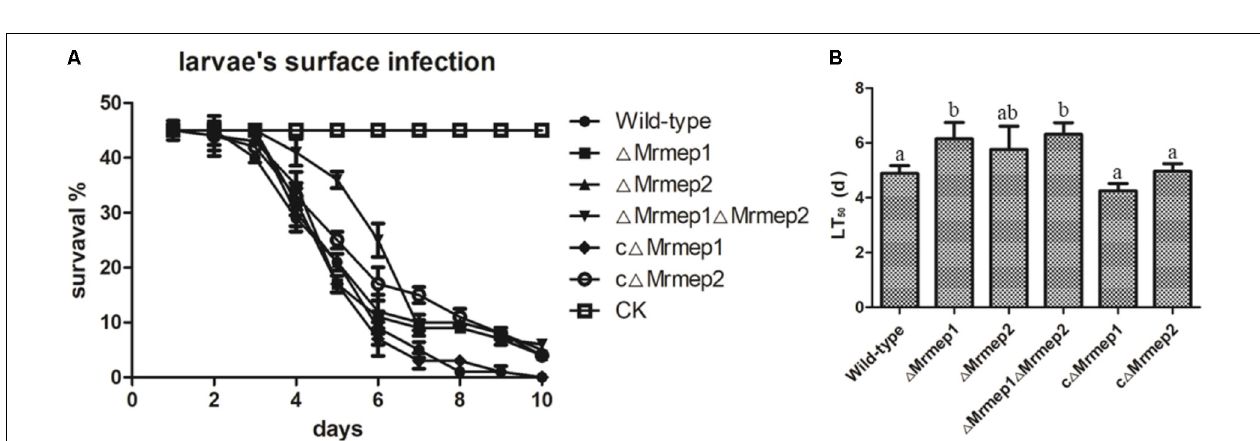
FIGURE 5 | Insect bioassays to assess the loss of Mrmep1 and Mrmep2 using the larvae of G. mellonella as hosts. (A) Survival curves of G. mellonella larvae after injection with fungal conidia of WT, (cid:49) Mrmep1 , (cid:49) Mrmep2 , (cid:49) Mrmep1 (cid:49) Mrmep2 , c (cid:49) Mrmep1 , or c (cid:49) Mrmep2 strains. Conidial suspensions (3 µ L) at 1 × 10 7 conidia mL - 1 were injected into each larva. (B) LT 50 of the different mutant strains.